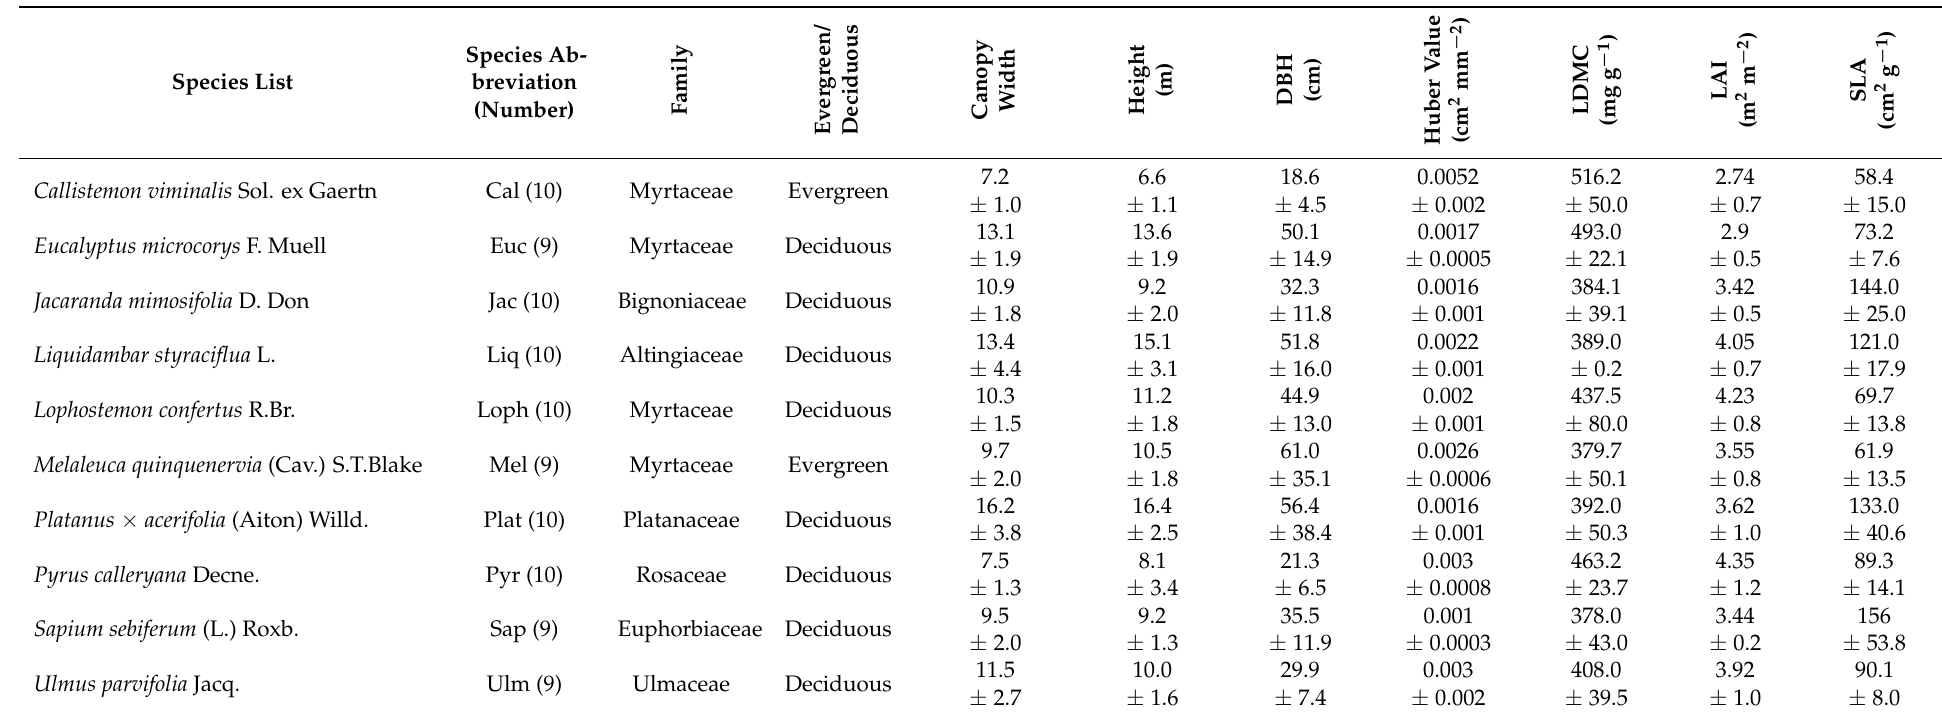
Table 1. Mean and standard deviation of the characteristics of the 10 tree species selected in Richmond and Cranebrook, Greater Sydney, Australia. Numbers of individual trees are given in